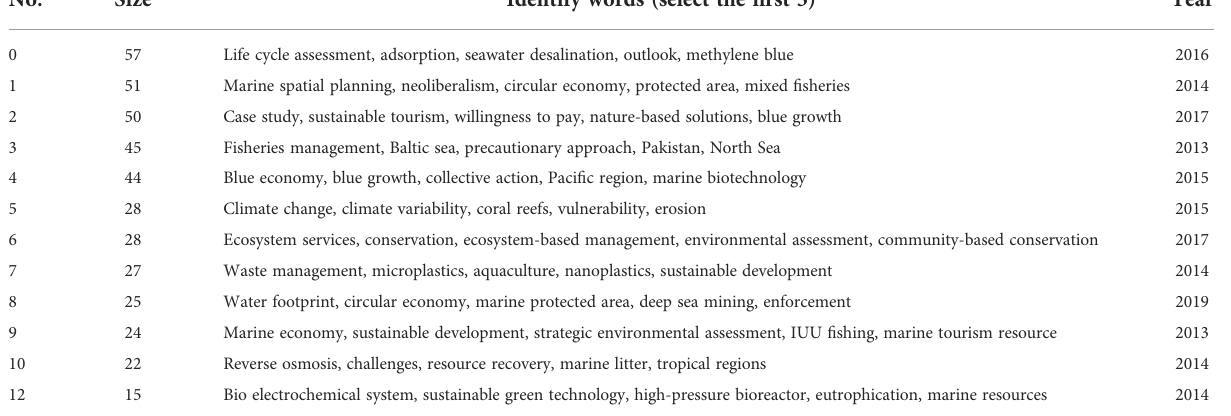
TABLE 10 Keyword cluster co-occurrence list.